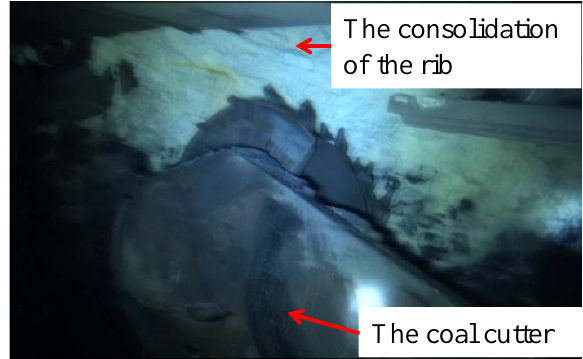
Figure 20. Coal wall and roof consolidation.